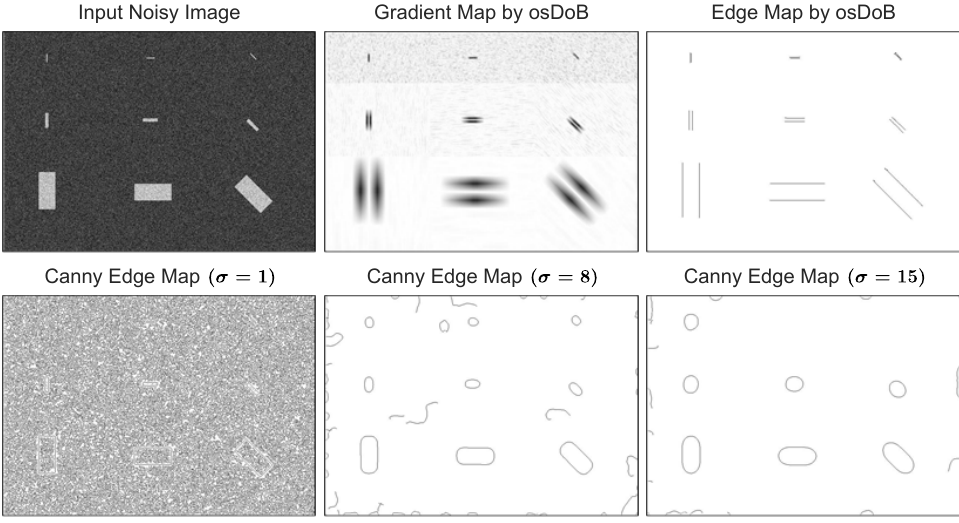
Figure 10. Performance of the proposed method and Canny detector on a noisy synthesized